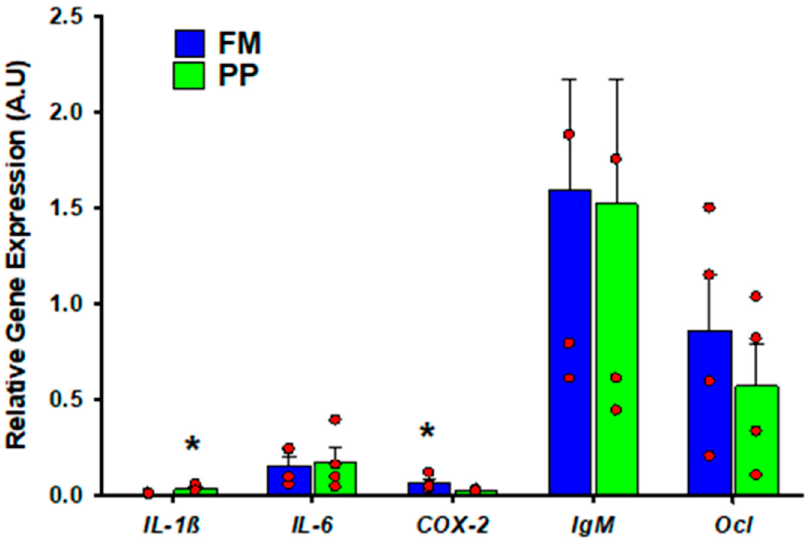
Figure 1. The intestinal basal expression of fish exposed to plant protein (PP) diet in Phase I (68 g). Relative gene expression (A.U.) of the different genes is expressed by the mean and standard error. Asterisks on the bars indicate significant differences ( p < 0.05). Sample data in each experimental group are represented by red spots. Fish Meal (FM) diet. Interleukin 1 β : IL-1 β ; Interleukin 6:I L-6; Cyclooxygenase 2: COX-2; Immunoglobulin M: IgM; Occludin: Ocl .